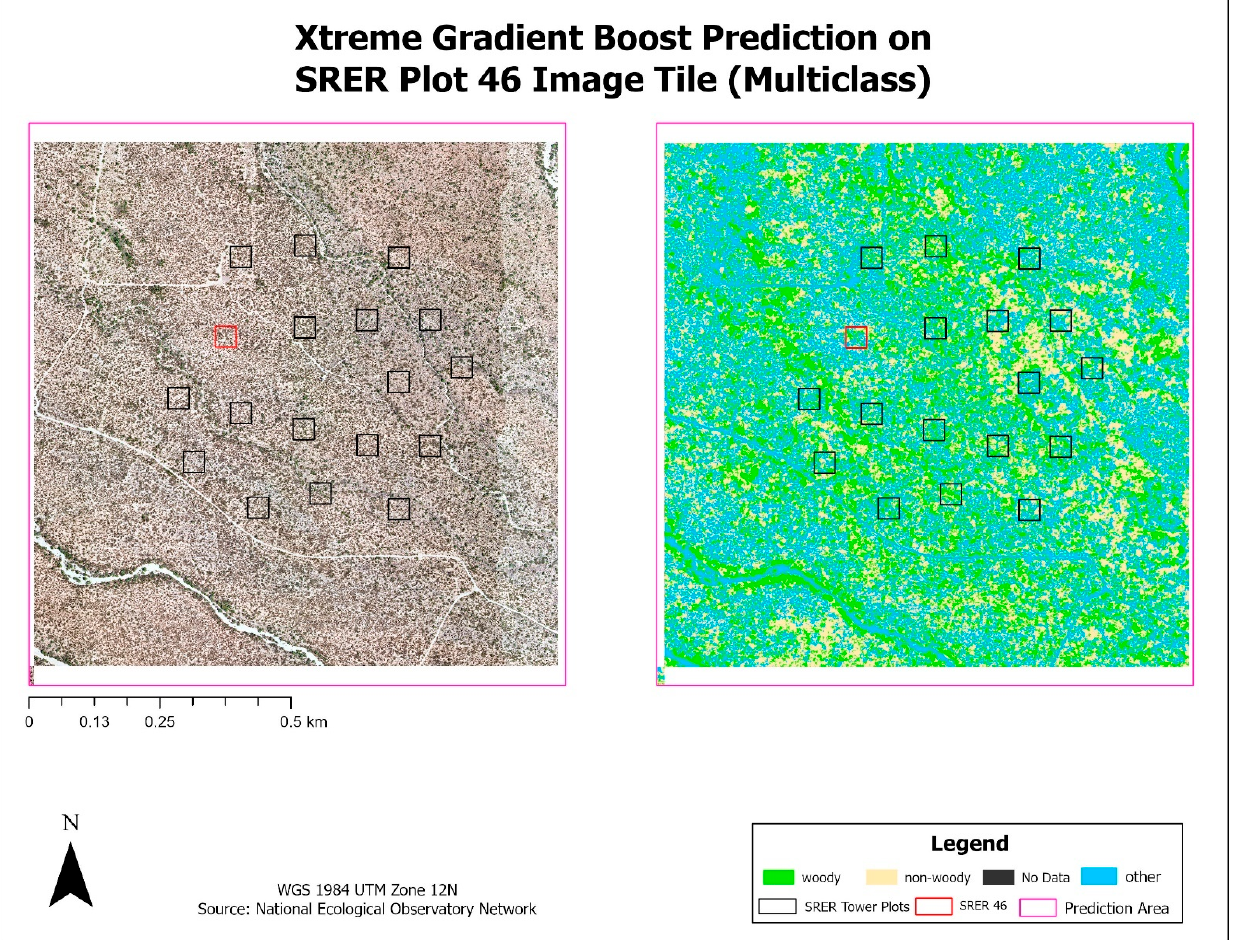
Figure 10. XGB model predictions for the Plot 46 image tile using a multiclass classification scheme. FWC for the entire prediction area is 33.1%. Major woody vegetation patterns appear in green for both the RGB and prediction tile, with areas of bare ground, roads, and water features being classi- fied in blue as “other”. Areas being classified as non-woody appear to have a reddish soil color or have areas of less-green